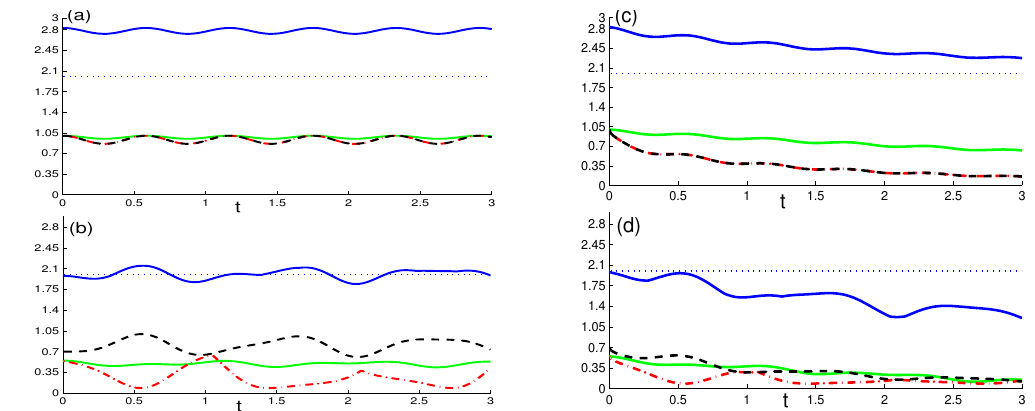
Figure 6. The L ( t ) (dashed plots), U ( t ) (dashed dotted plots), B ( t ) (upper solid plots), and N ( t ) (solid plots) for χ z = 0.5, ∆ = 1.5, p = 1, J x = J z = 2 and γ = 0.0 for: p = 1 in panel ( a ) and p = 0.7 in panel ( b ). While in panels ( c , d ) γ = 0.4.